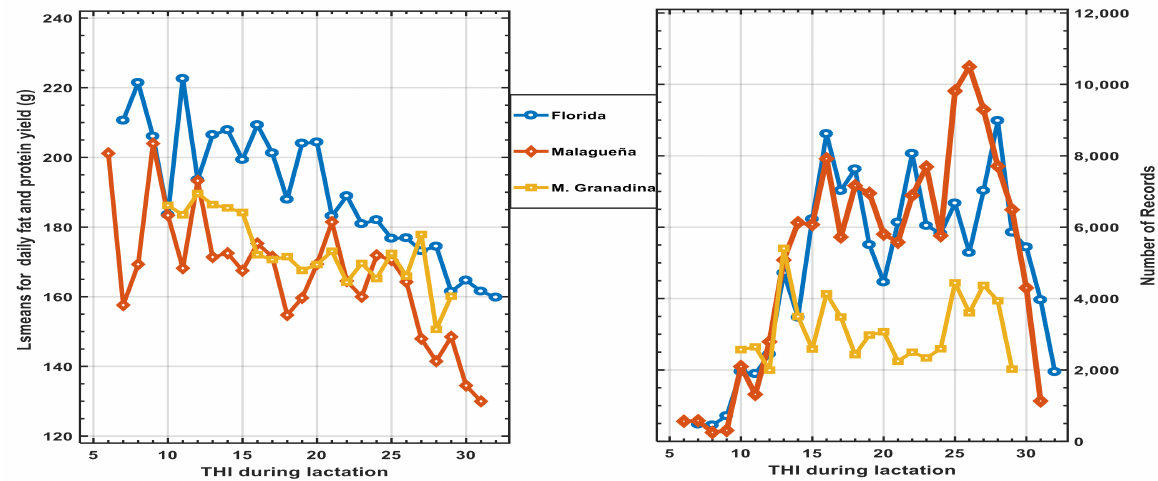
Figure 1. Least square means and distribution of records showing the effect of temperature and relative humidity index ( THI ) level during lactation on total daily fat and protein yield in three Spanish dairy goat